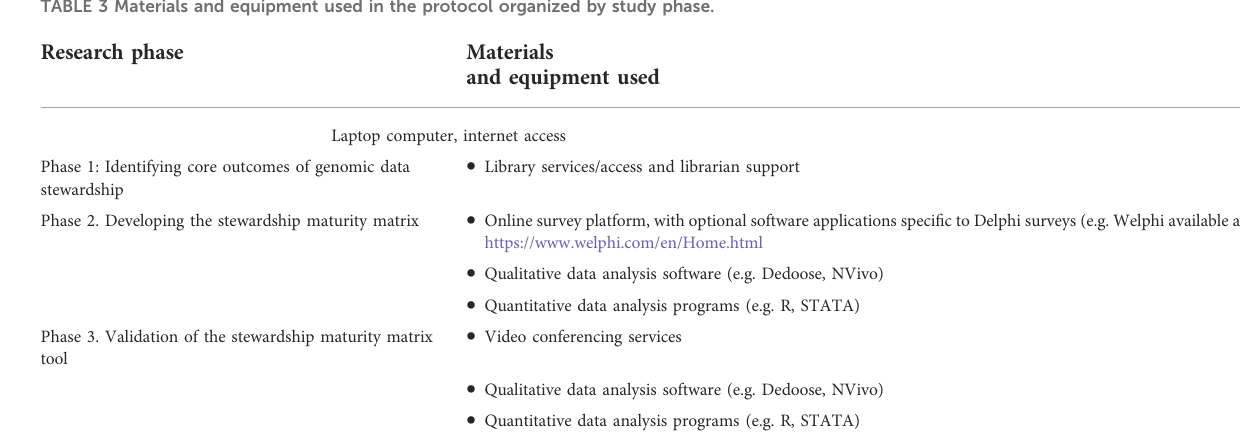
TABLE 3 Materials and equipment used in the protocol organized by study